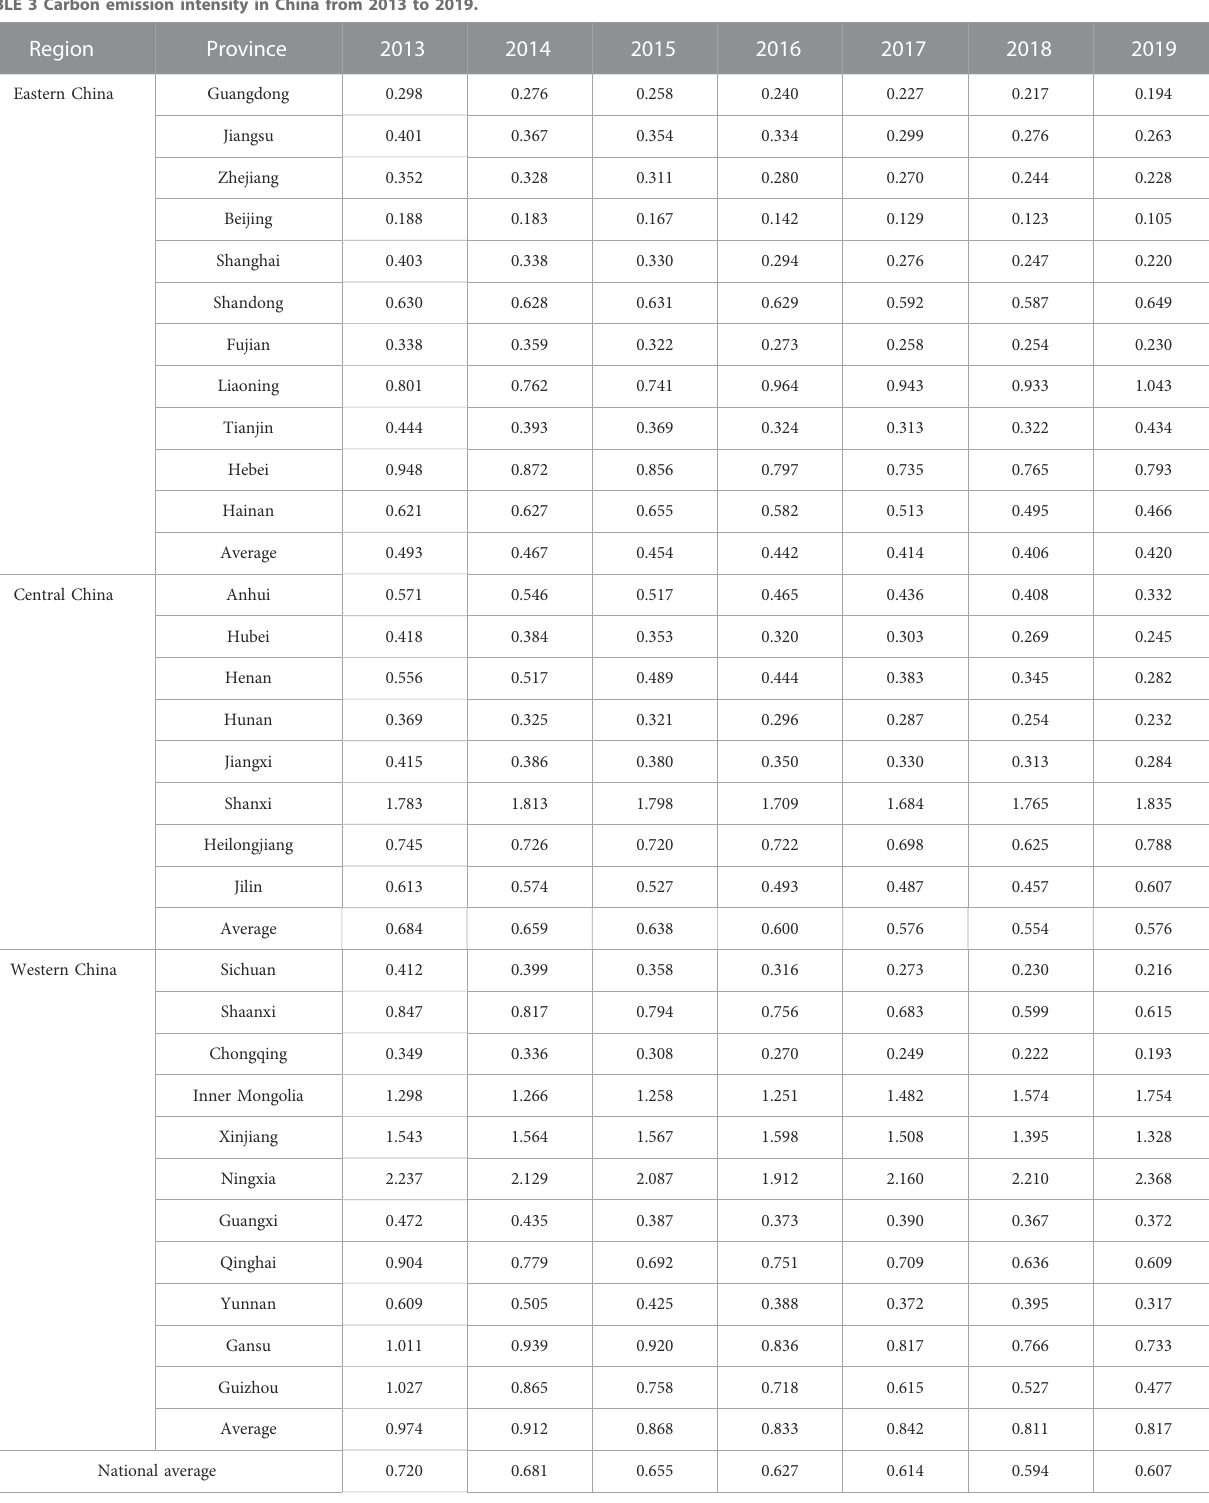
TABLE 3 Carbon emission intensity in China from 2013 to